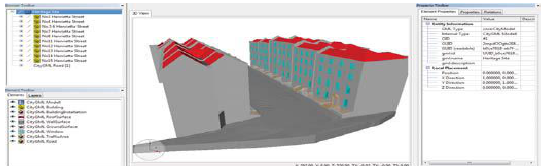
Figure 3. Final HBIM Model of the Henrietta Street (Dore et al.,